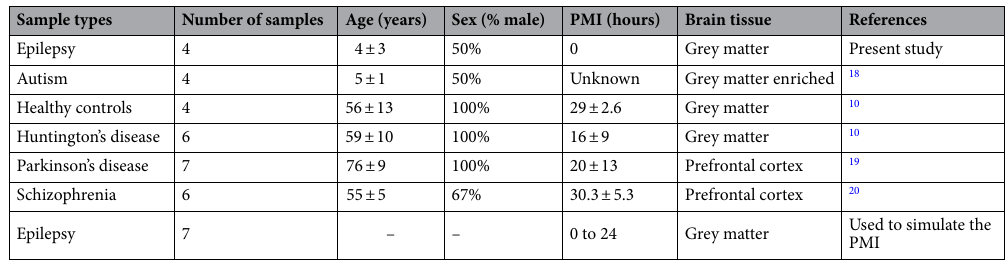
Table 1. Samples and RNAseq data used in this study.